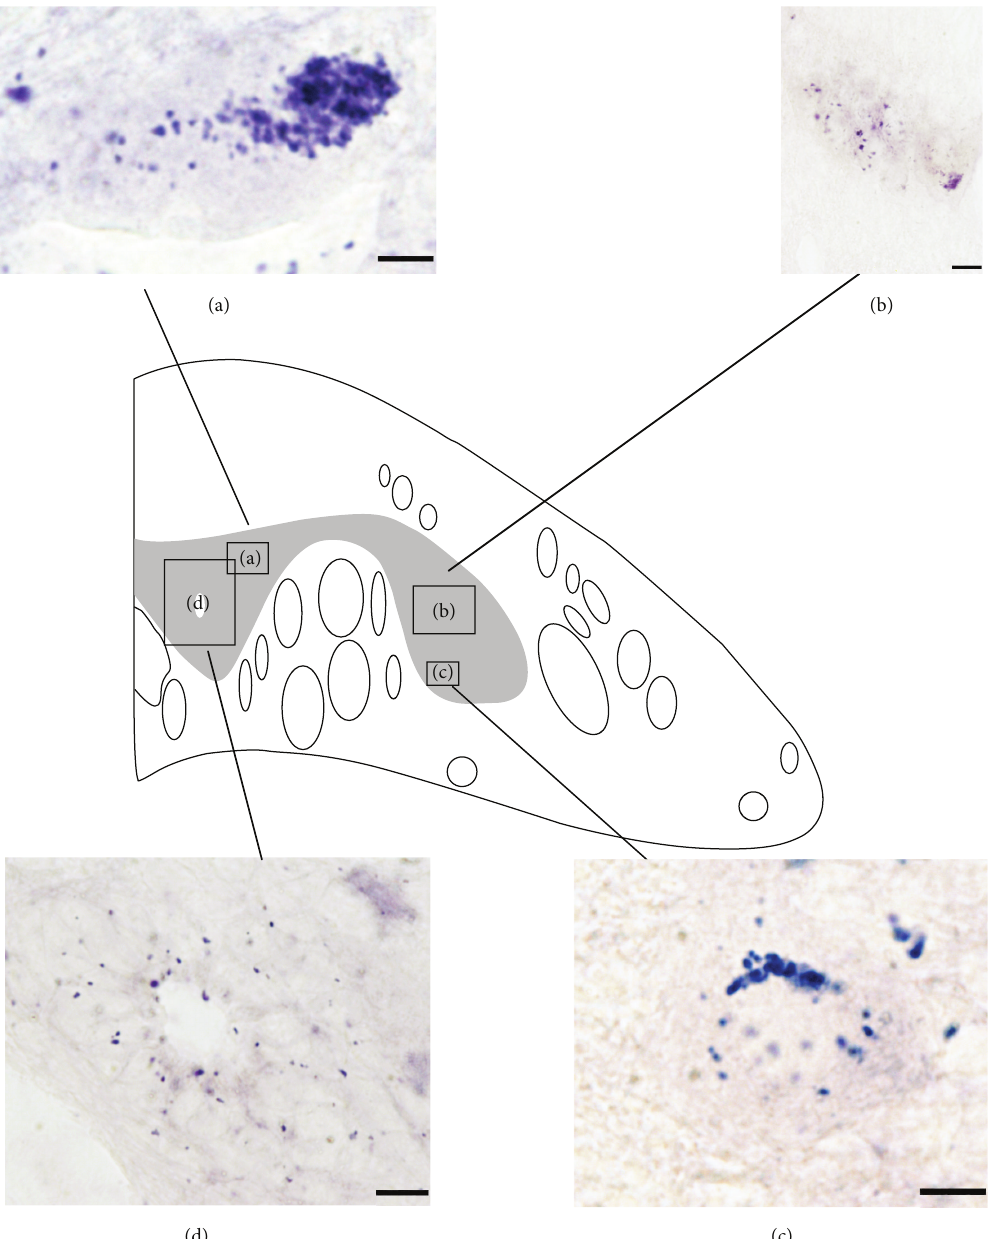
Figure3:ExpressionoftheD2receptorincontrolanimals.(a)DorsalcellshowingexpressionoftheD2transcriptinitssoma.(b)Interneurons showing expression of D2 transcript. (c) Expression of D2 transcripts in CSFc and ependymal glial cells around the central canal. (d) Expression D2 transcripts in spinal motor neurons. In all microphotographs dorsal is at the top. Scale bars = 50 𝜇 m.